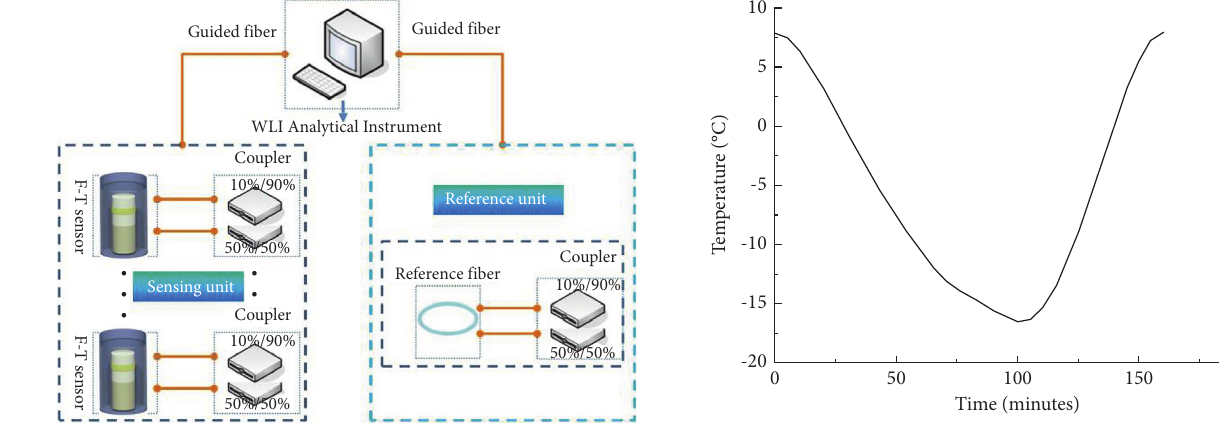
Figure 4: The diagram of the F-T monitoring system.